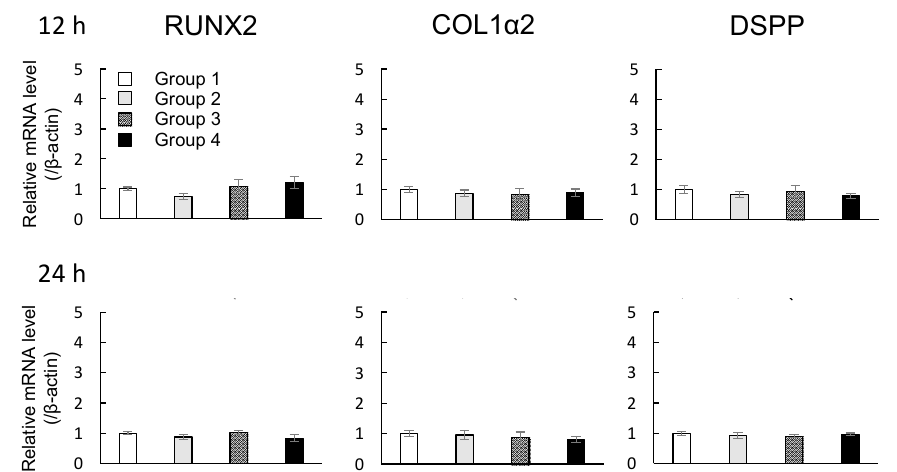
Figure 4. Effects of MNPs and/or magnetic force on the expression levels of RUNX2, COL1 α 2 , and DSPP in cultured DMCs examined by real-time RT-PCR. Real-time RT-PCR data were normalized to the expression levels of β -actin mRNA. Independent experiments were repeated twice. Data represent the mean ± SD of triplicate samples. p > 0.05, ANOVA.